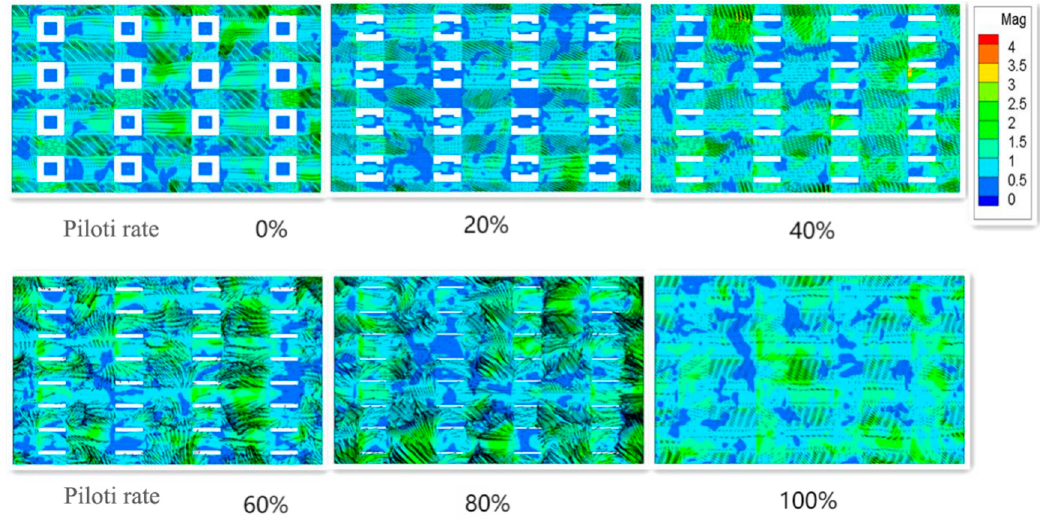
Figure 18. Vector diagram of the target area of the pedestrian layer.